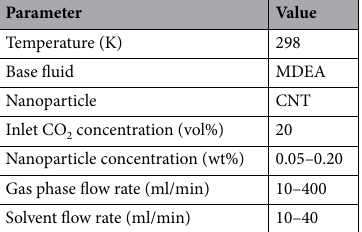
Table 1. Experimental conditions for membrane CO 2 capture.